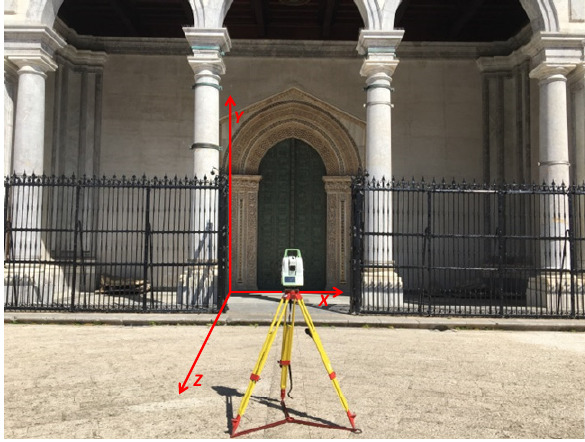
Figure 8. Image acquisition phase Overall seven strips, from different heights with respect to the ground, were performed; figure 9 shows the different camera height